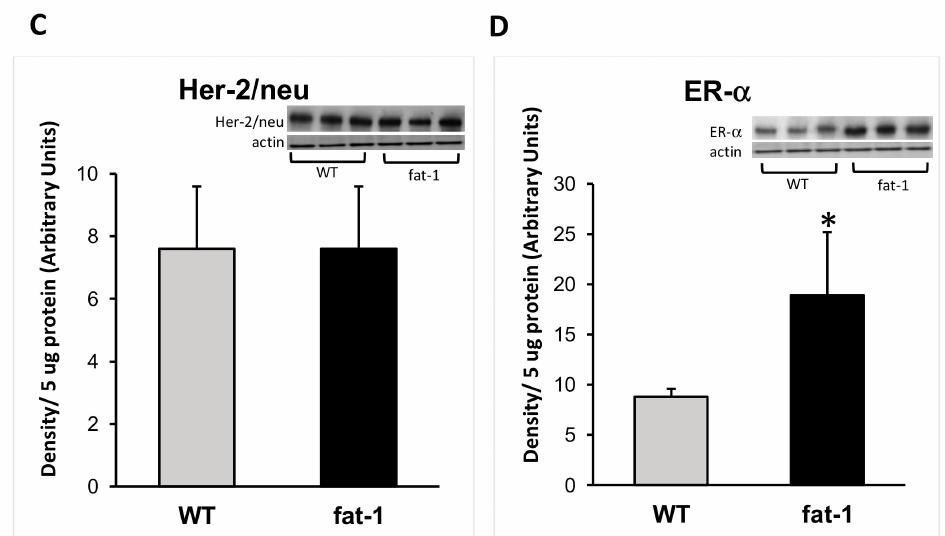
Figure 3. Epithelial cell numbers and protein expression, including representative Western blots, in caveolae isolated from mammary epithelial cells of wildtype (WT) and fat-1 mice: ( A ) epithelial cell numbers, ( B ) Cav-1, ( C ) Her-2 / neu, ( D ) ER- α . * denotes a significant di ff erence at p ≤ 0.05 by Student’s t -test.